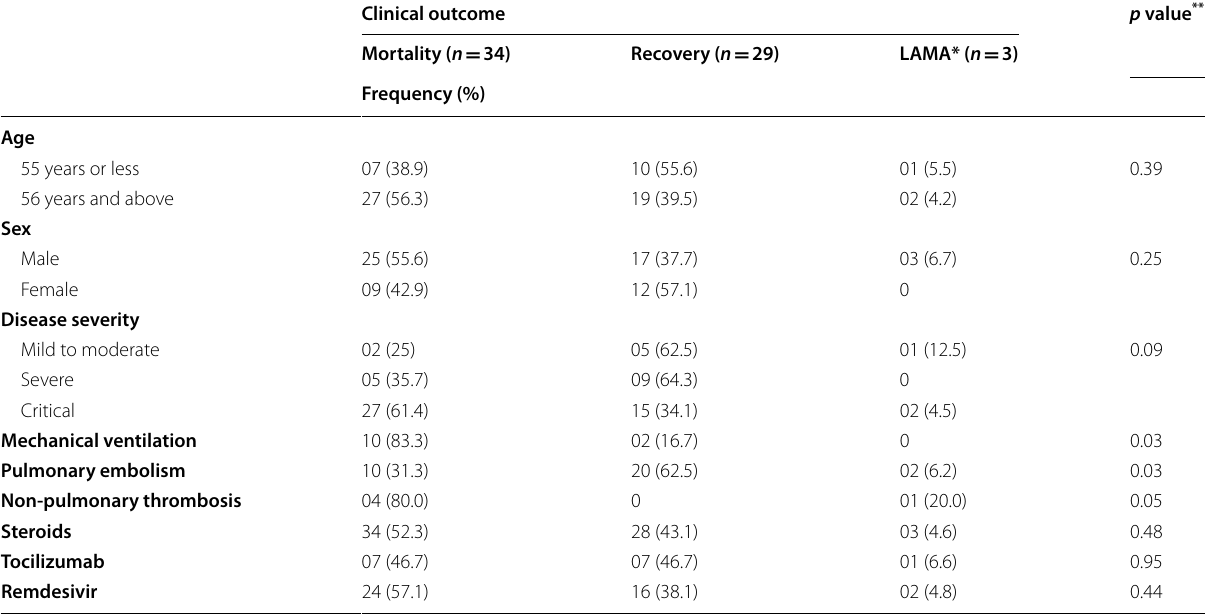
Table 2 Comparison of disease outcomes among PCR confirmed COVID-19 patients on the basis of basic demographic characteristics, coagulation profile, and disease severity ( n